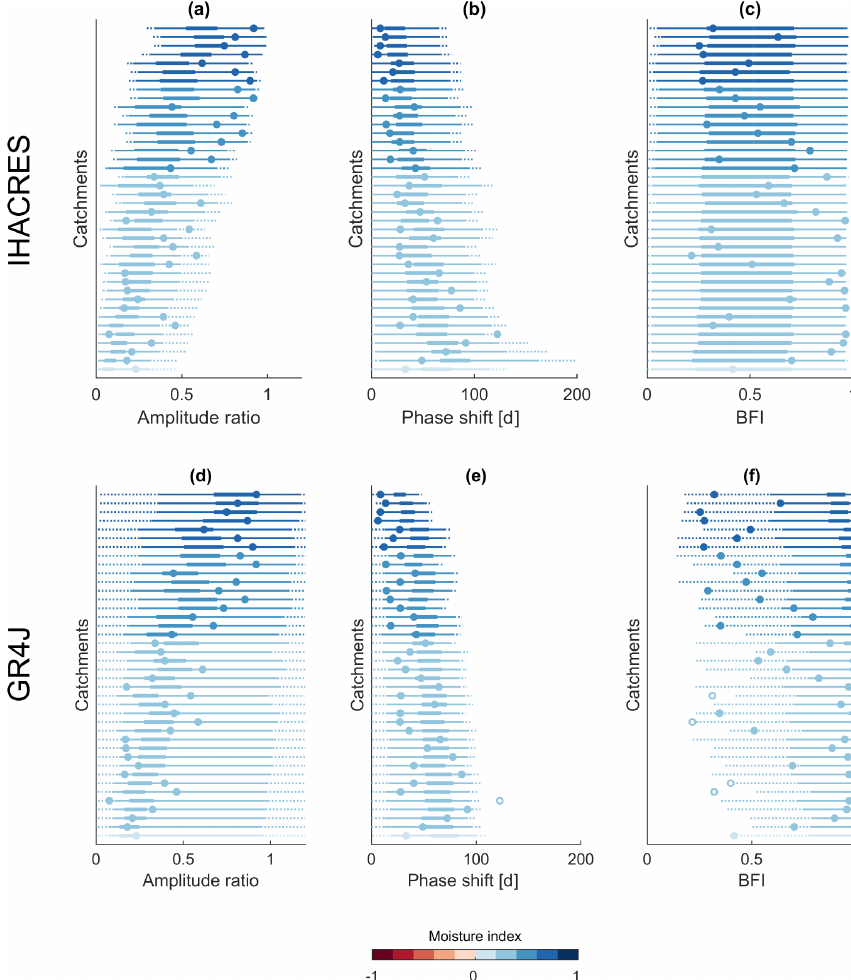
Figure 9. Distributions of different hydrological signatures resulting from the modelling experiment. Each line stands for one of the 40 catch- ments, and the colours indicate the corresponding moisture index. The distributions of the modelled signatures are indicated by box-whisker- type plots. The thick line spans from the 25th to the 75th percentile. The thin line spans from the 1st (75th) to the 25th (99th) percentile. The dotted line indicates values below (above) the 1st (99th) percentile. The circles indicate the observed signature values, while filled circles indicate that the observed signature is inside the modelled signature space and vice versa. Panels (a) , (b) , and (c) show results for IHACRES. Panels (d) , (e) , and (f) show results for GR4J. Model runs with amplitude ratios lower than 0.01, amplitude ratios larger than 1.2, or phase shifts larger than 200d have been